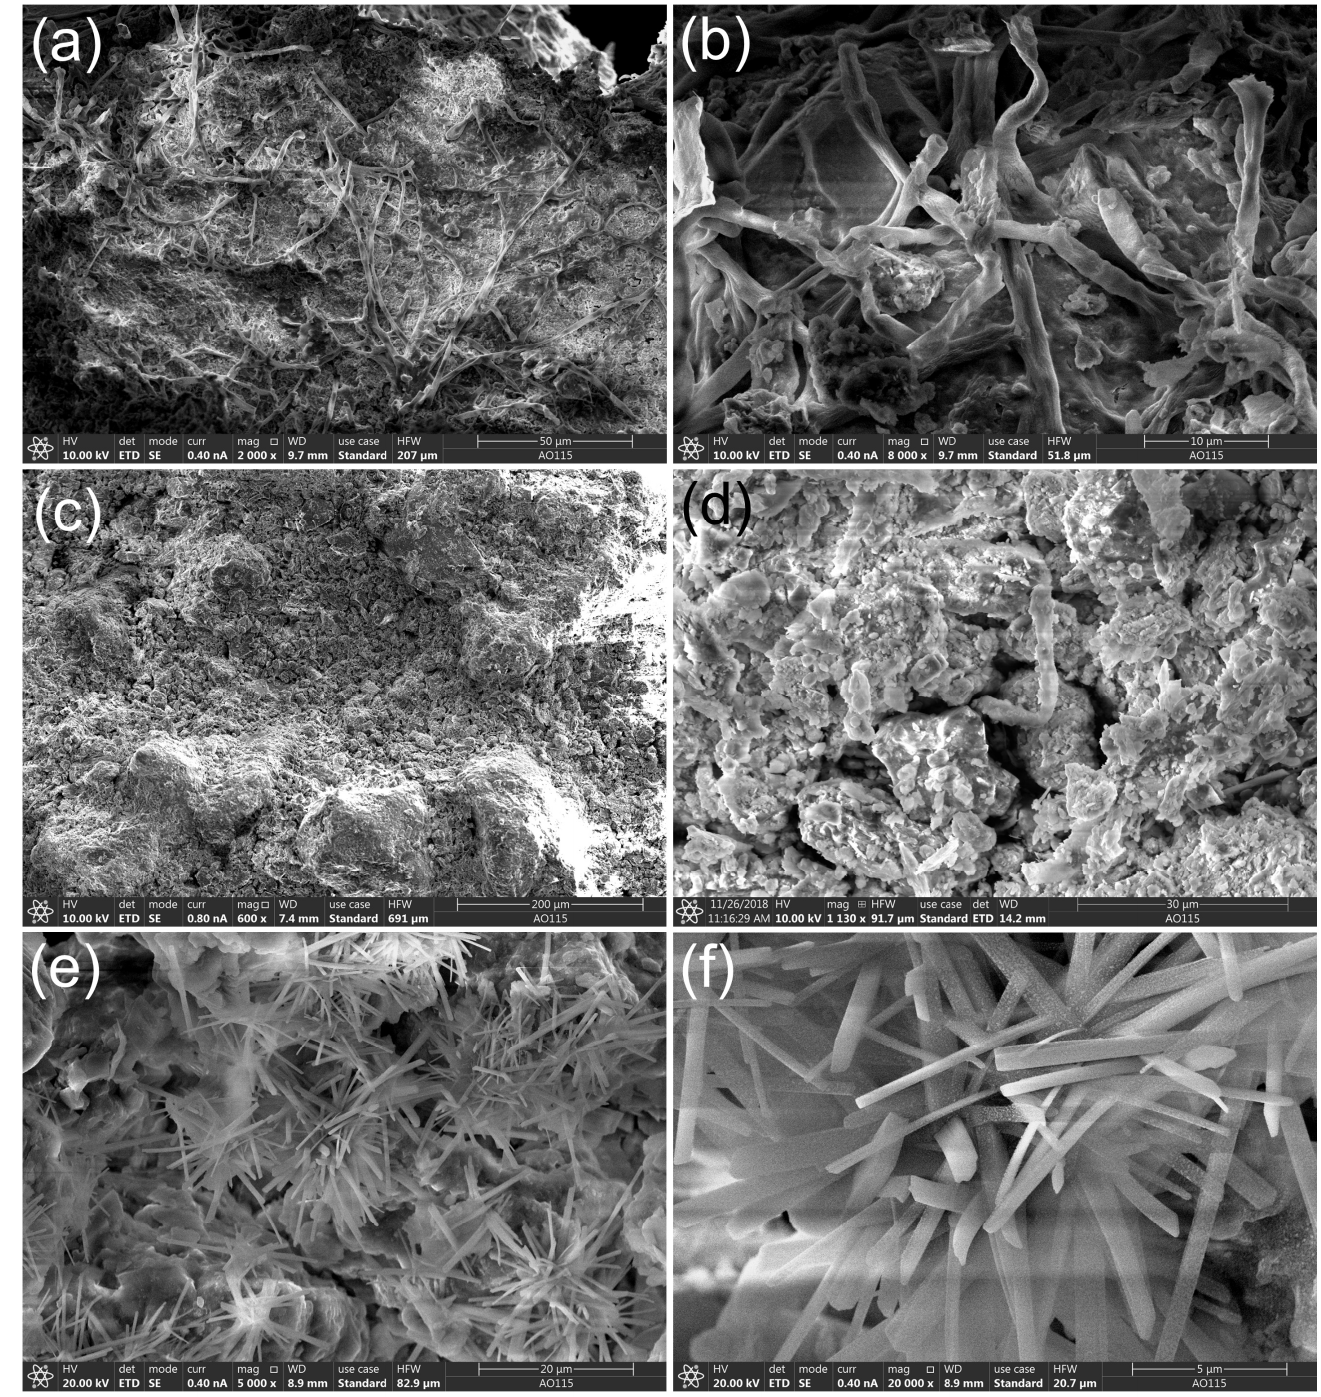
Figure 2. Morphological structures of sandstone samples from Beishiku Temple. Scanning electron micrographs (SEM) of microbial hyphal colonization ( a , b ), weathered sandstone ( c , d ), and salt crystal efflorescence ( e , f ).